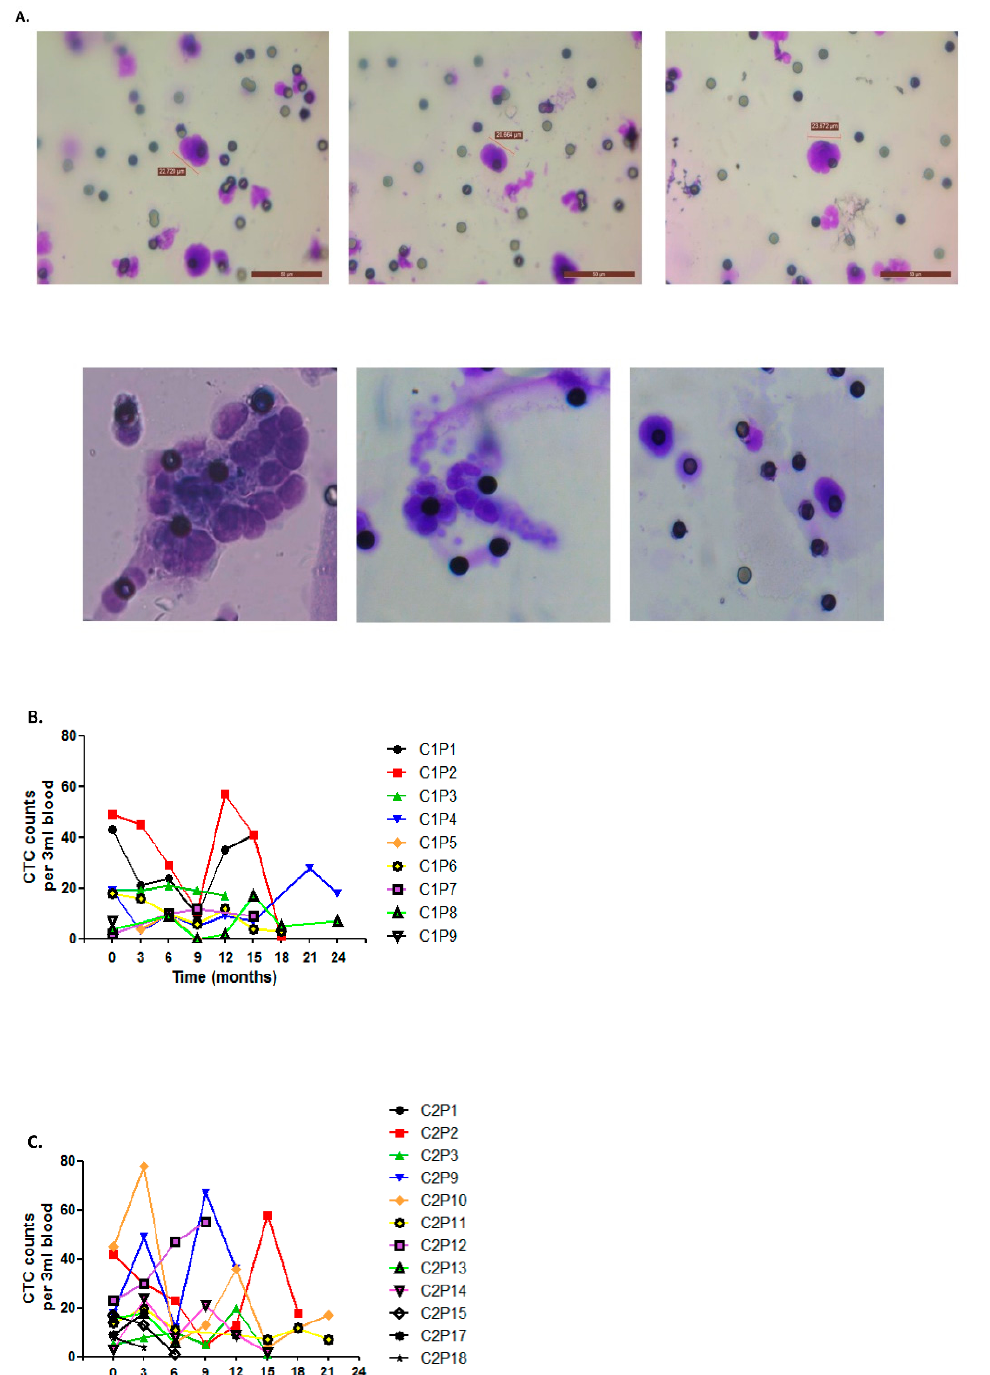
Figure 4. Prospective staining and enumeration of CTCs using ScreenCell ® Cyto filters during treatment with EGFR TKIs. CTCs were isolated from liquid biopsies at each 3 month time-point using ScreenCell ® Cyto filters based on size exclusion technology. Filters were stained with May–Grünwald Giemsa stain. Morphological assessment and CTC enumeration was carried out by an independent cytopathologist using an Olympus BX41 light microscope. Representative images of CTCs are shown at × 20 magnification ( A ). Longitudinal analysis of CTCs as markers of disease burden and response to EGFR TKI therapy was assessed in EGFR cohort 1 ( B ) and cohort 2 ( C ) at baseline and during the 2 year follow-up period.